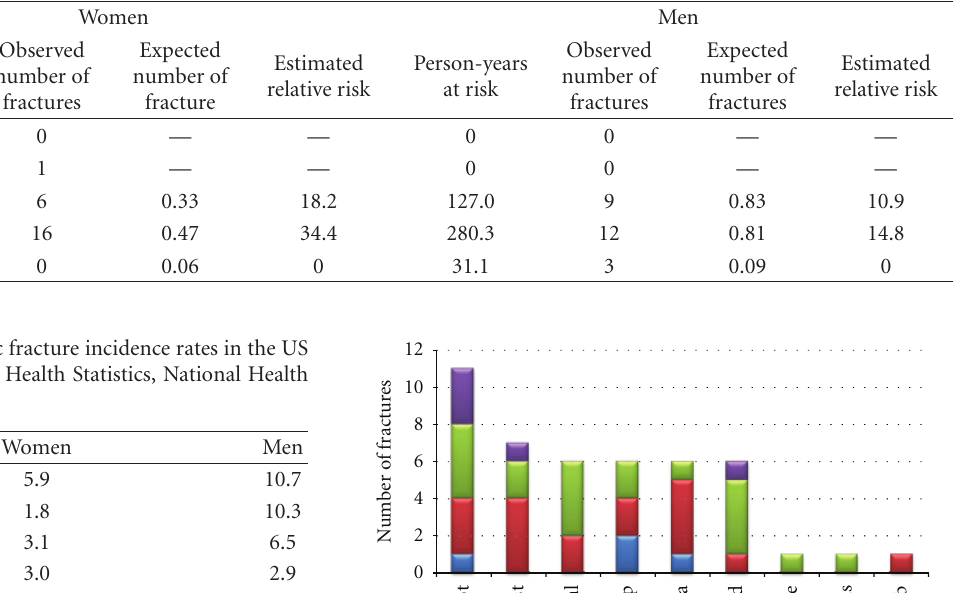
Table 2: Age- and gender-specific fracture incidence rates in all transplant recipients.